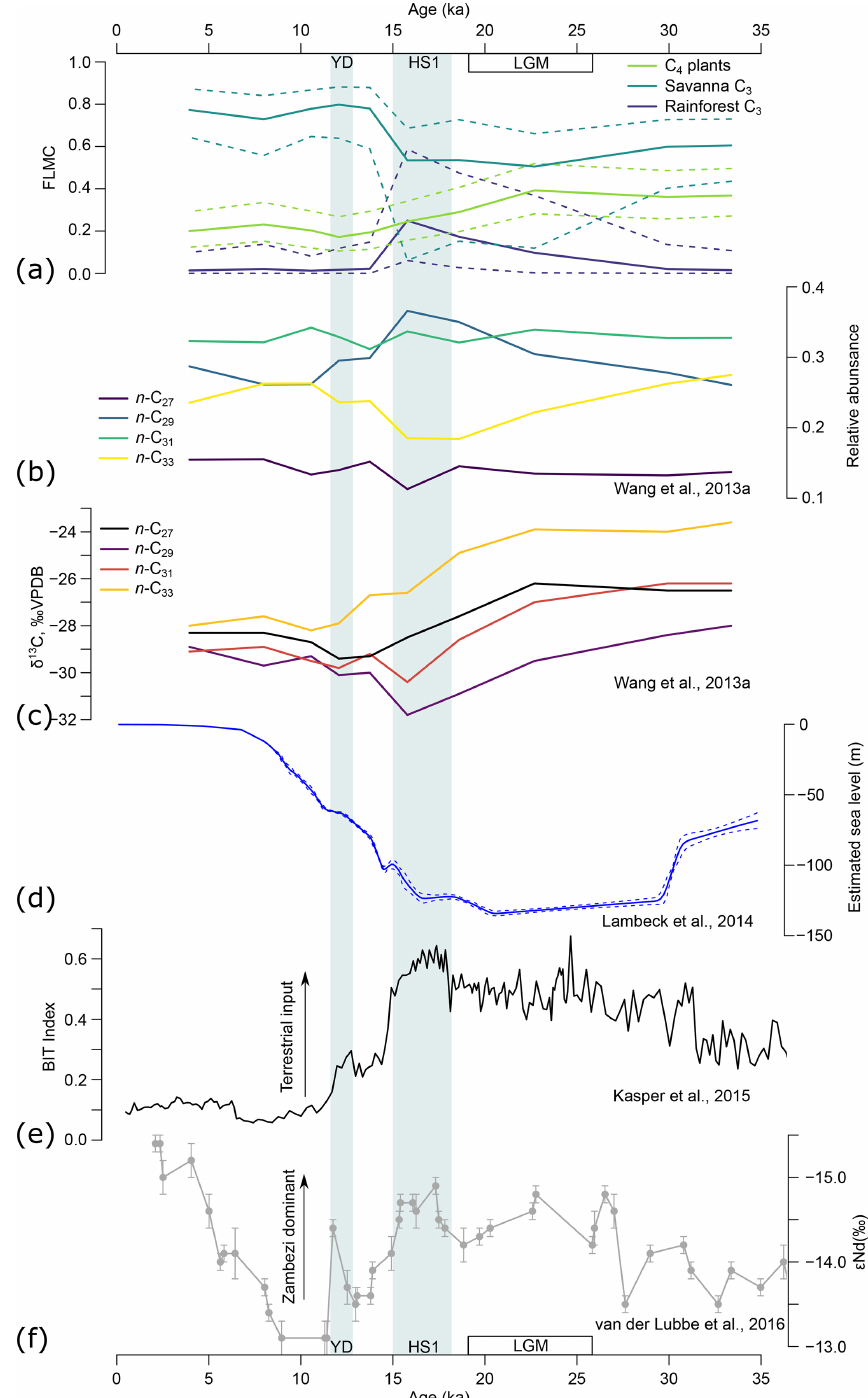
Figure 11. (a) Model estimates of fractional leaf mass contribution (FLMC) of three broadly defined biomes through time, based on n - alkane data of the GIK 16160-3 core (Wang et al., 2013a). Solid lines represent maximum a posteriori estimates (MAPE) of the three sources. Dashed lines represent the 89% highest density interval (HDI) of the posterior distributions. (b) The n -alkane relative abundance and (c) n -alkane δ 13 C of the same core (Wang et al., 2013a). (d) Global sea level change (Lambeck et al., 2014). (e) BIT index indicating terrestrial sedimentary input (Kasper et al., 2015). (f) The ε Nd of clay indicating relative influence of the Zambezi River (van der Lubbe et al., 2016). YD represents the Younger Dryas ( ∼ 13–11ka). HS1 represents Heinrich Stadial 1 ( ∼ 18–15ka). LGM represents the Last Glacial Maximum ( ∼